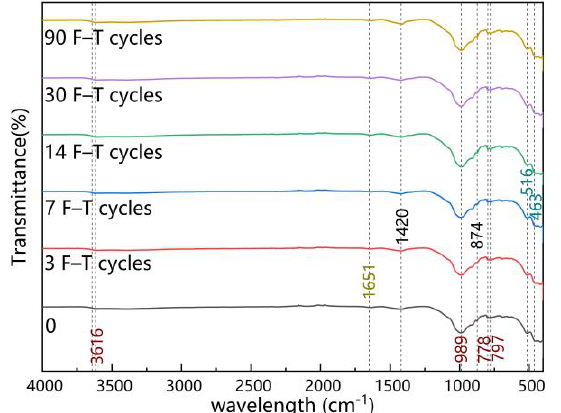
Figure 6. FTIR spectra of S/S Pb–Zn–Cd composite HMs-contaminated soil under 6 F–T cycle conditions (0, 3, 7, 14, 30, and 90